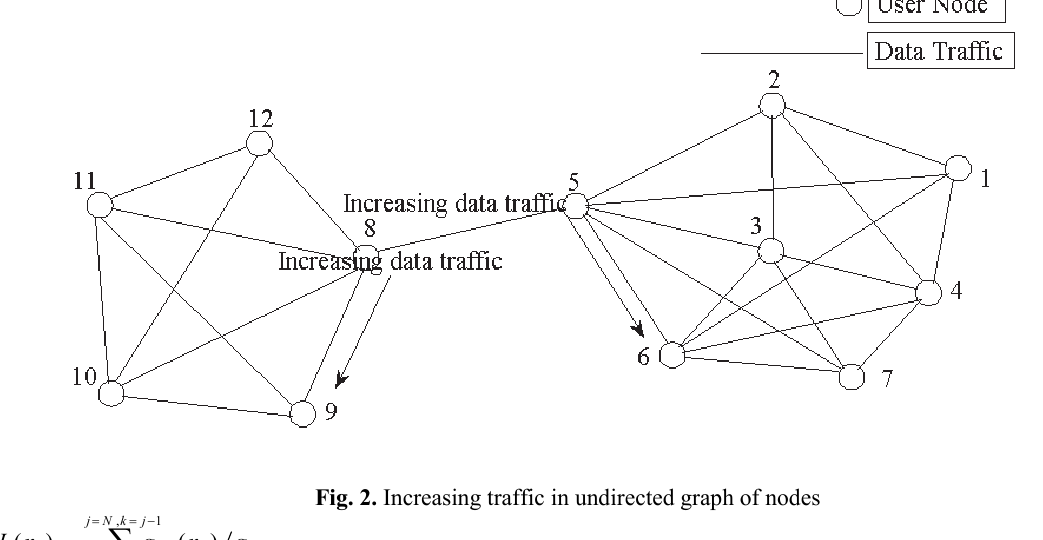
Fig. 2. Increasing traffic in undirected graph of